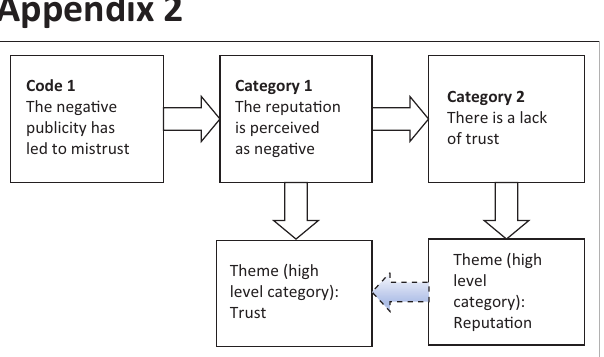
FIGURE 1-A2: Illustration of the coding approach using an adapted version of grounded